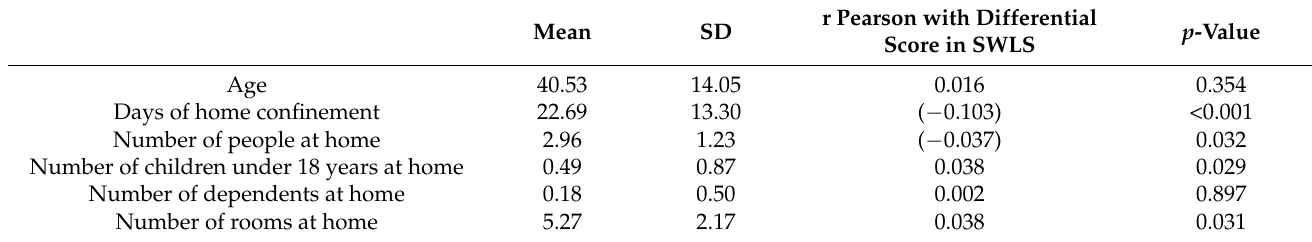
Table 2. Correlation between differential scores in the SWLS and quantitative